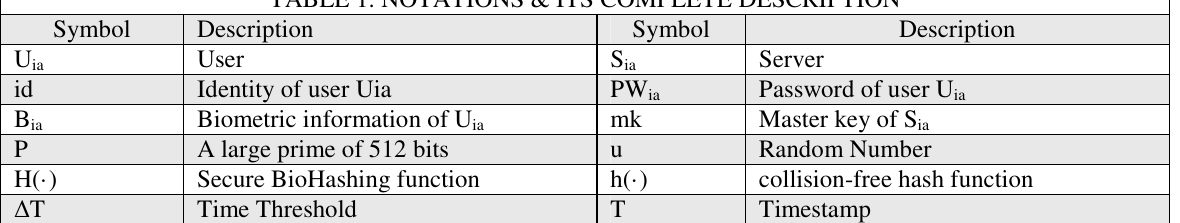
TABLE 1. NOTATIONS & ITS COMPLETE